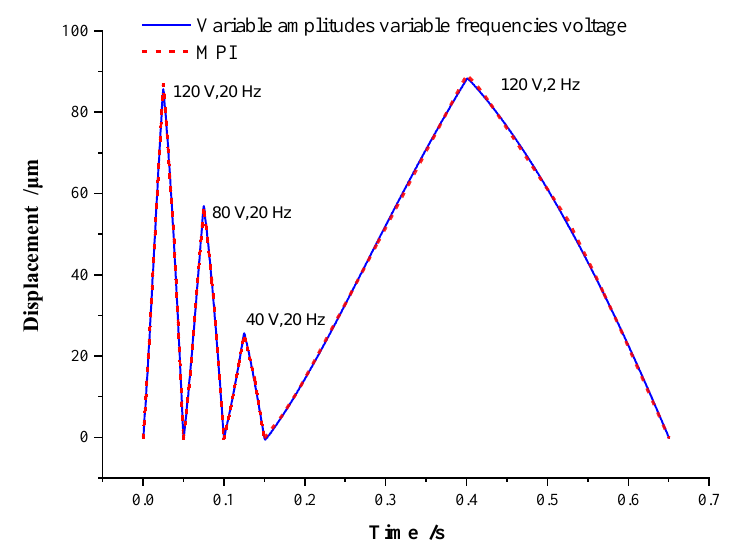
Figure 8. MPI accuracy on variable amplitudes variable frequencies voltage.